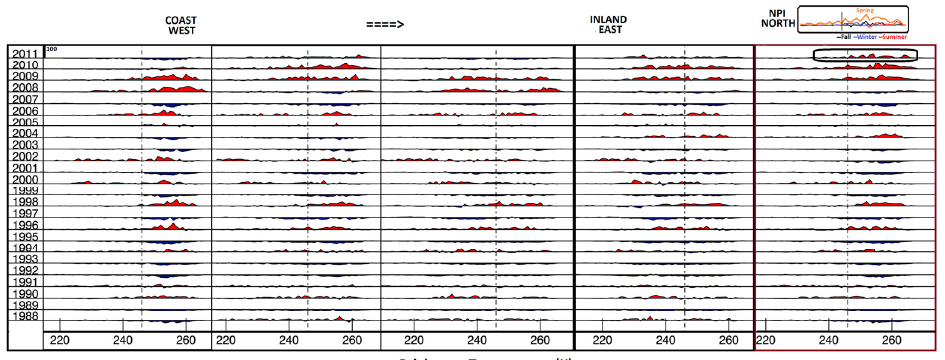
The black oval above the last panel is shows seasonal components (spring is orange; fall is black; winter is blue; summer is red). Vertical black line in each panel is the 246 K melt threshold. For scale, the y-axis distance between each year line is